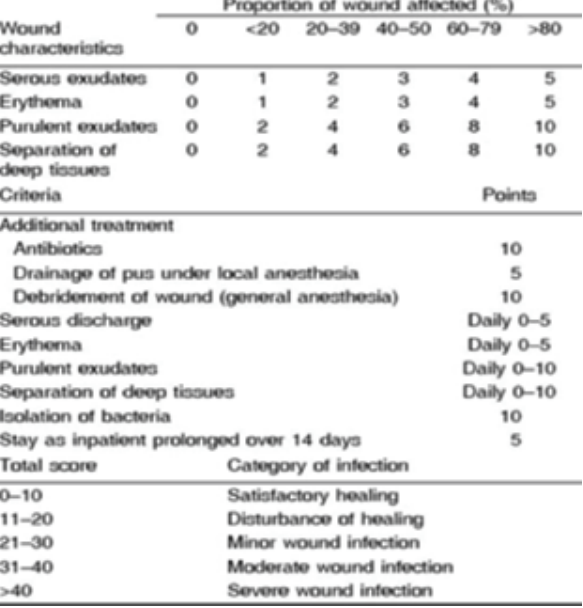
Figure-I: Asepsis scoring system.